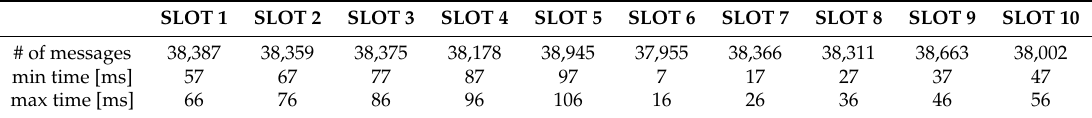
Table 2. WSN alarm notification message benchmark